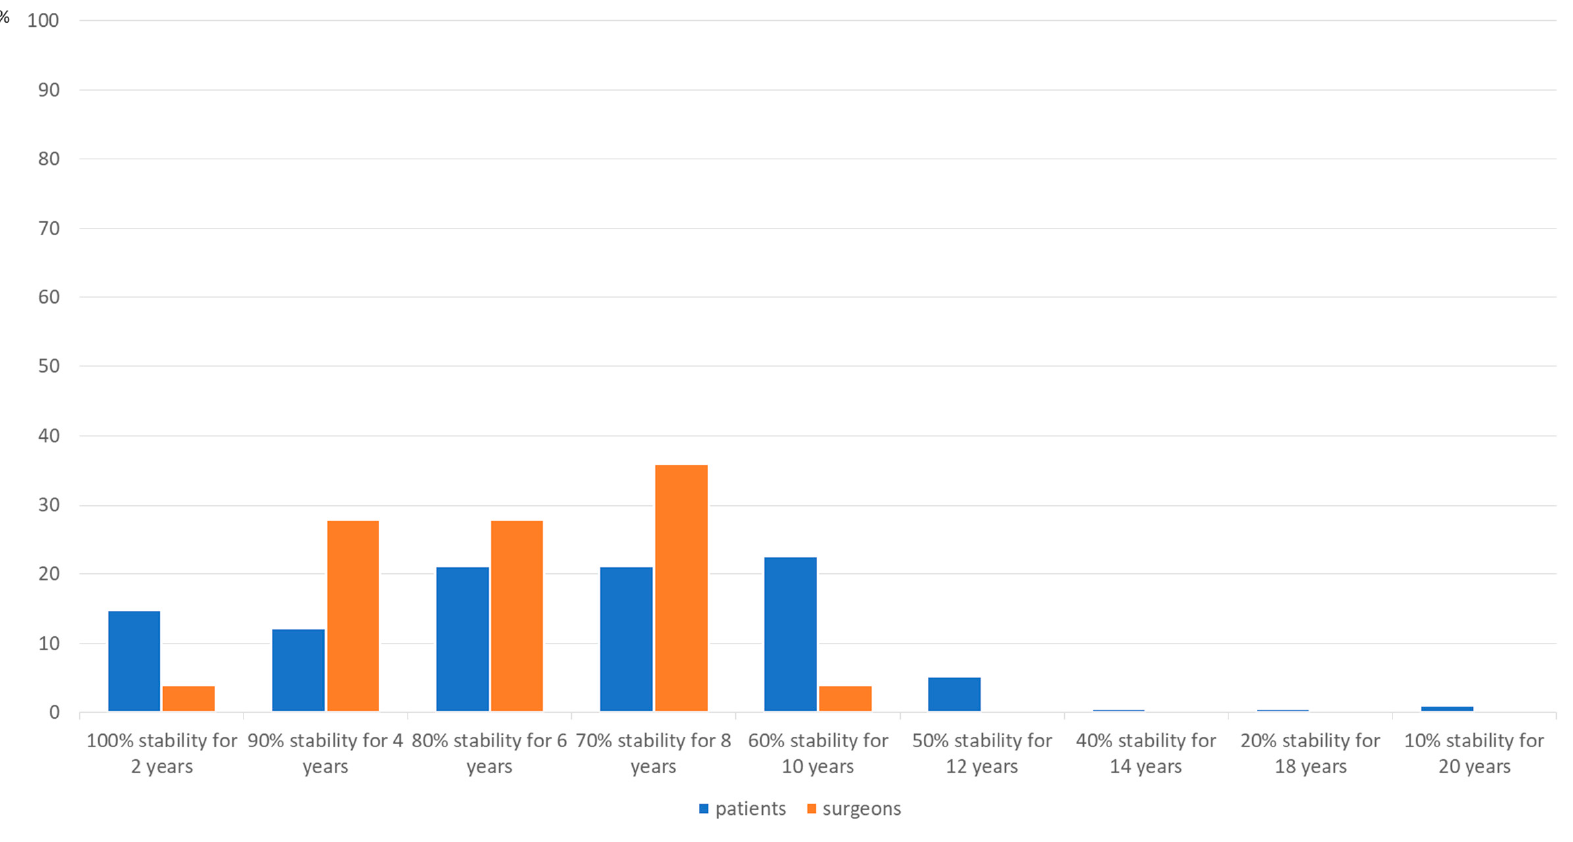
Figure 4. Preferred stability over time ( p = 0.163, r = 0.095).